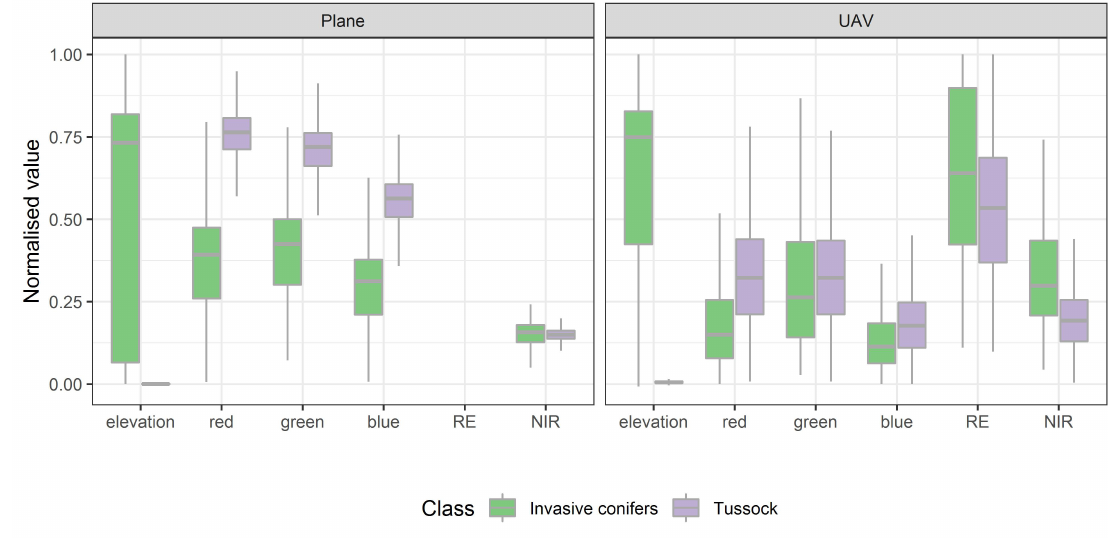
Figure 4. Box and whisker plots of the spectral and structural properties of the training dataset for the manned aircraft (Plane) and UAV